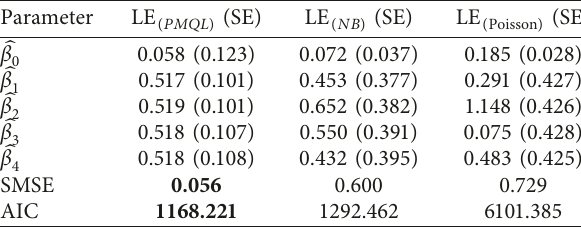
Figure 2: The distribution of the response variable y . Table 11: The estimated regression coefficients, standard errors (in parentheses), SMSE values, and AIC values of different Liu re- gression models for the simulated data set.